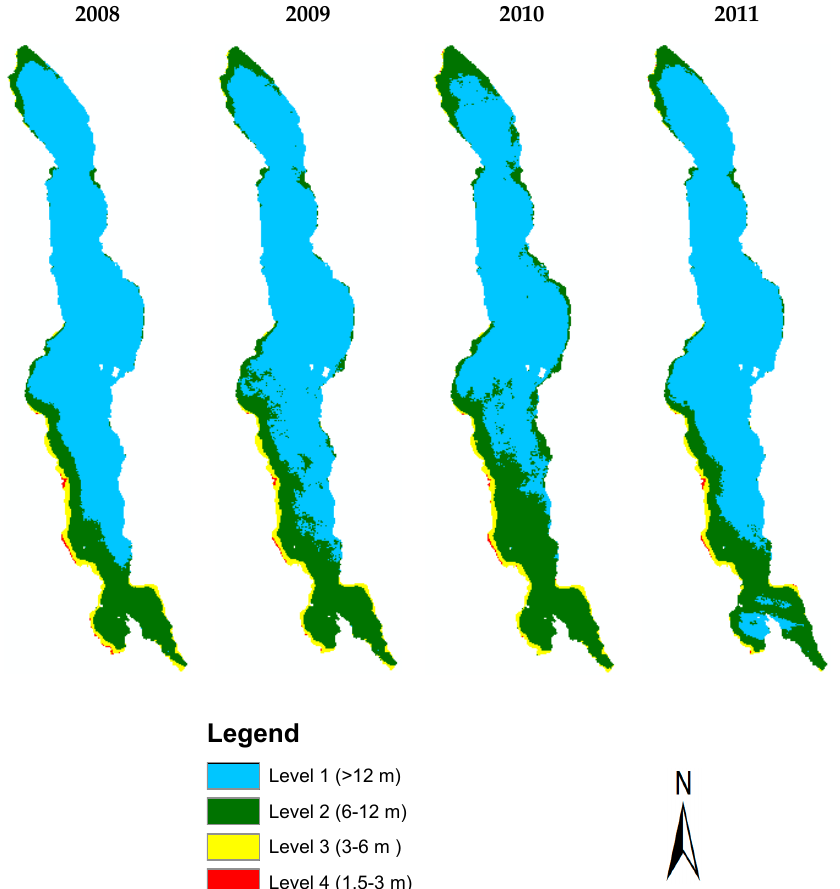
Figure 6. Yearly water transparency level maps in Lake Malawi. These maps were generated from yearly SD distribution maps (obtained from MERIS data using the Lee15 algorithm) based on the Economic Cooperation and Development (OECD) classification system [36]. Table 6. Yearly percentage for each water transparency level shown in (Figure 6).